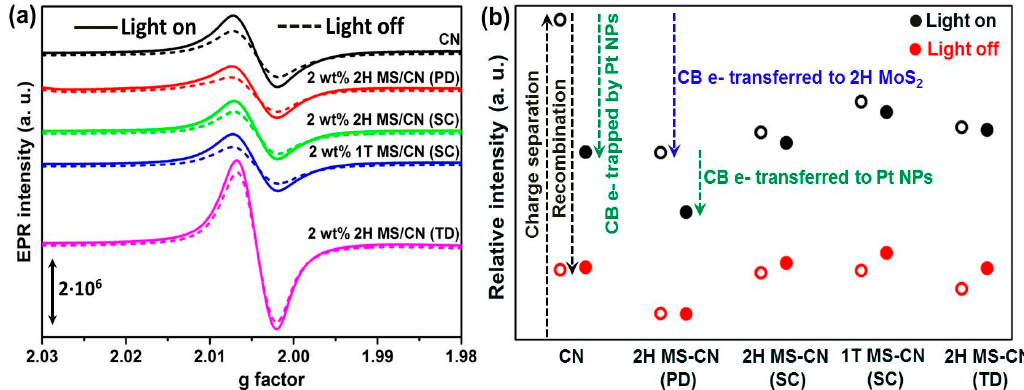
Figure 6. ( a ) Electron paramagnetic resonance (EPR) spectra of as-prepared catalysts during UV-vis light irradiation (solid lines) and after light switch-off (dashed lines). ( b ) Double integral of the EPR CB e − signal (initial background signal in the dark was subtracted) during UV-vis light irradiation (black circles) and after light switched-off (red circles). Hollow and solid circles represent fresh bare supports (without Pt NPs) and used catalysts (with Pt NPs), respectively.